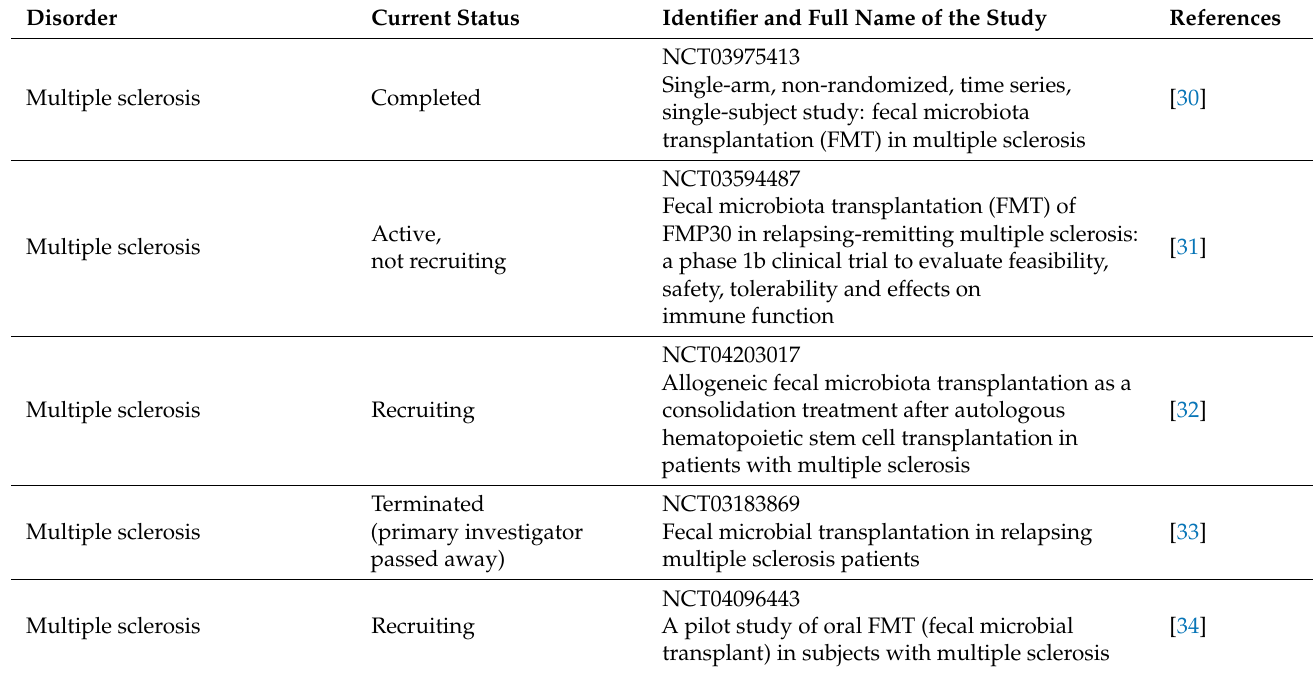
Table 2. Ongoing clinical trials applying FMT as an intervention in autoimmune diseases. The table summarizes ongoing clinical trials in which human donor stool was applied to ameliorate the onset, slowdown the progression or suppress the symptoms of autoimmune diseases, namely celiac disease, multiple sclerosis, psoriatic arthritis, rheumatoid arthritis, Sjogren’s syndrome and type I diabetes. The table summarizes the current status of the study as well as the specific identifier and full name of the